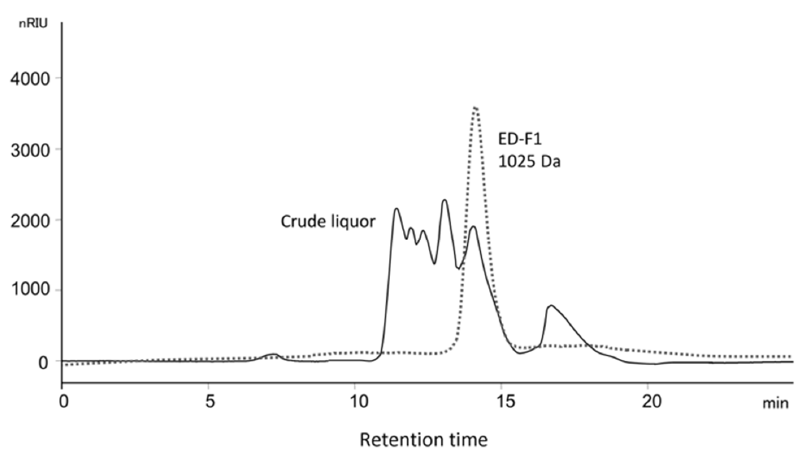
Figure 5. E. denticulatum ED ‐ F1 fraction observed under size ‐ exclusion chromatography (HP ‐